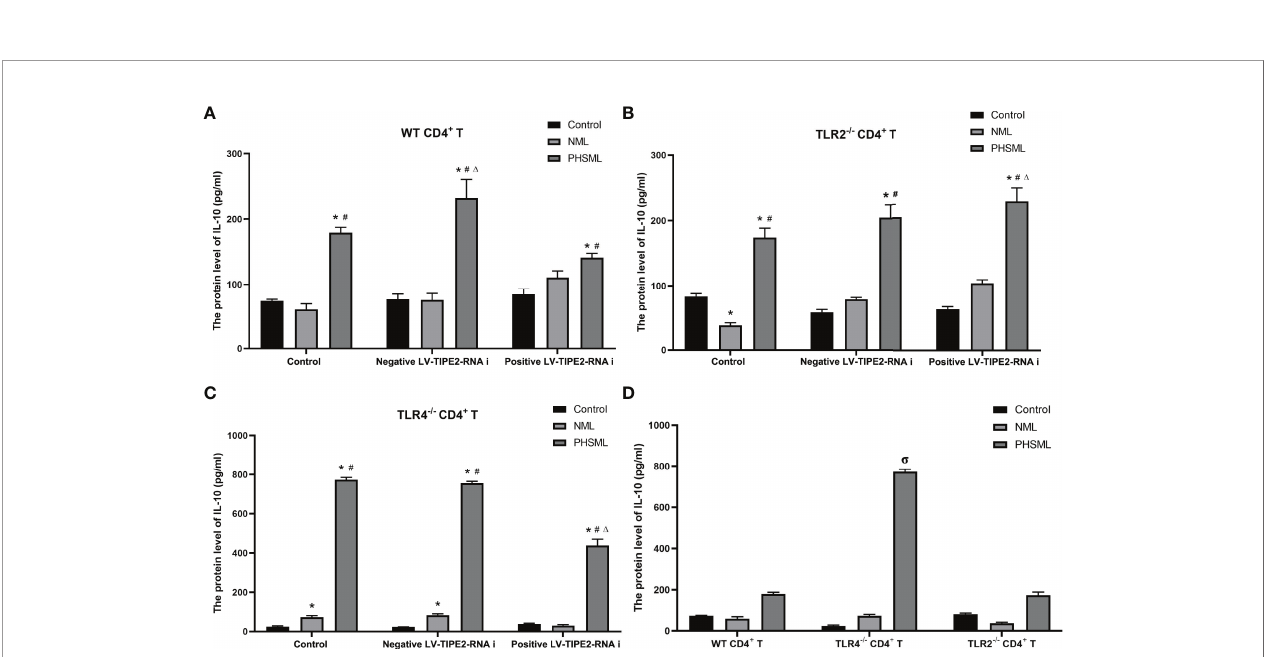
FIGURE 9 | The changes of IL-10 production in CD4 + T cells isolated from various mice. (A) The production of IL-10 in cultural supernatant of CD4 + T cells from WT mice infected with TIPE2 shRNA following by the stimulation with PHSML; (B) The production of IL-10 in cultural supernatant of CD4 + T cells from TLR2 -/- mice infected with TIPE2 shRNA following by the stimulation with PHSML detected by ELISA; (C) The production of IL-10 in cultural supernatant of CD4 + T cells from TLR4 -/- mice infected with TIPE2 shRNA following by the stimulation with PHSML detected by ELISA; (D) The production of IL-10 in cultural supernatant of CD4 + T cells from WT, TLR2 -/- or TLR4 -/- mice stimulated with PHSML detected by ELISA, respectively. Data are expressed as the mean ± SE (n = 6). *P < 0.05 vs control treated control group, #P < 0.05 vs NML treated control group, D P < 0.05 vs PHSML treated control group, s P < 0.05 vs PHSML treated WT CD4 + T